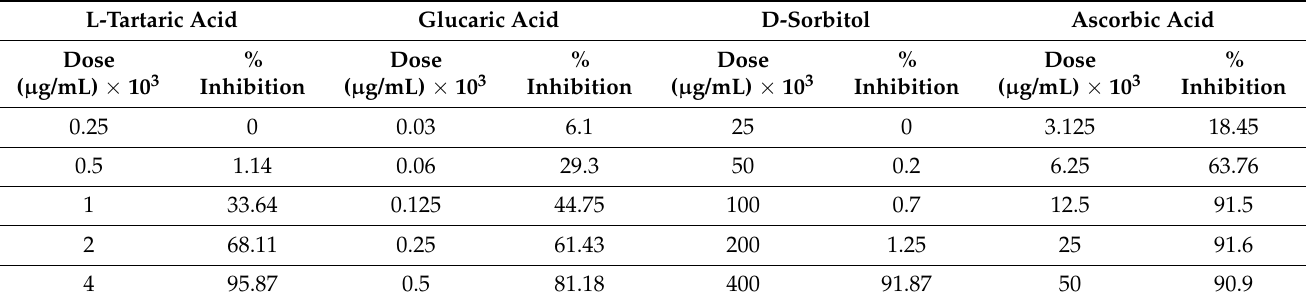
Table 4. In vitro study of ligand activity as an extracellular matrix biofilm inhibitor of Pseudomonas aeruginosa.